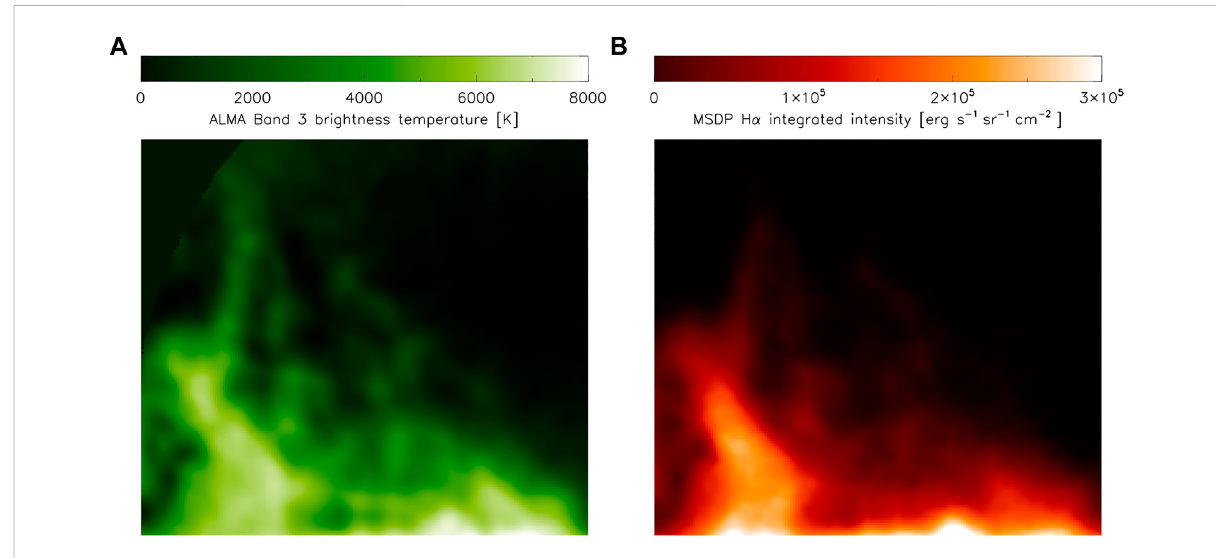
FIGURE 5 Coaligned maps of the brightness temperature T b obtained from calibrated ALMA Band 3 INT mosaic (A) and H α integrated intensities from MSDPWroc ł aw/Bia ł ków (B)